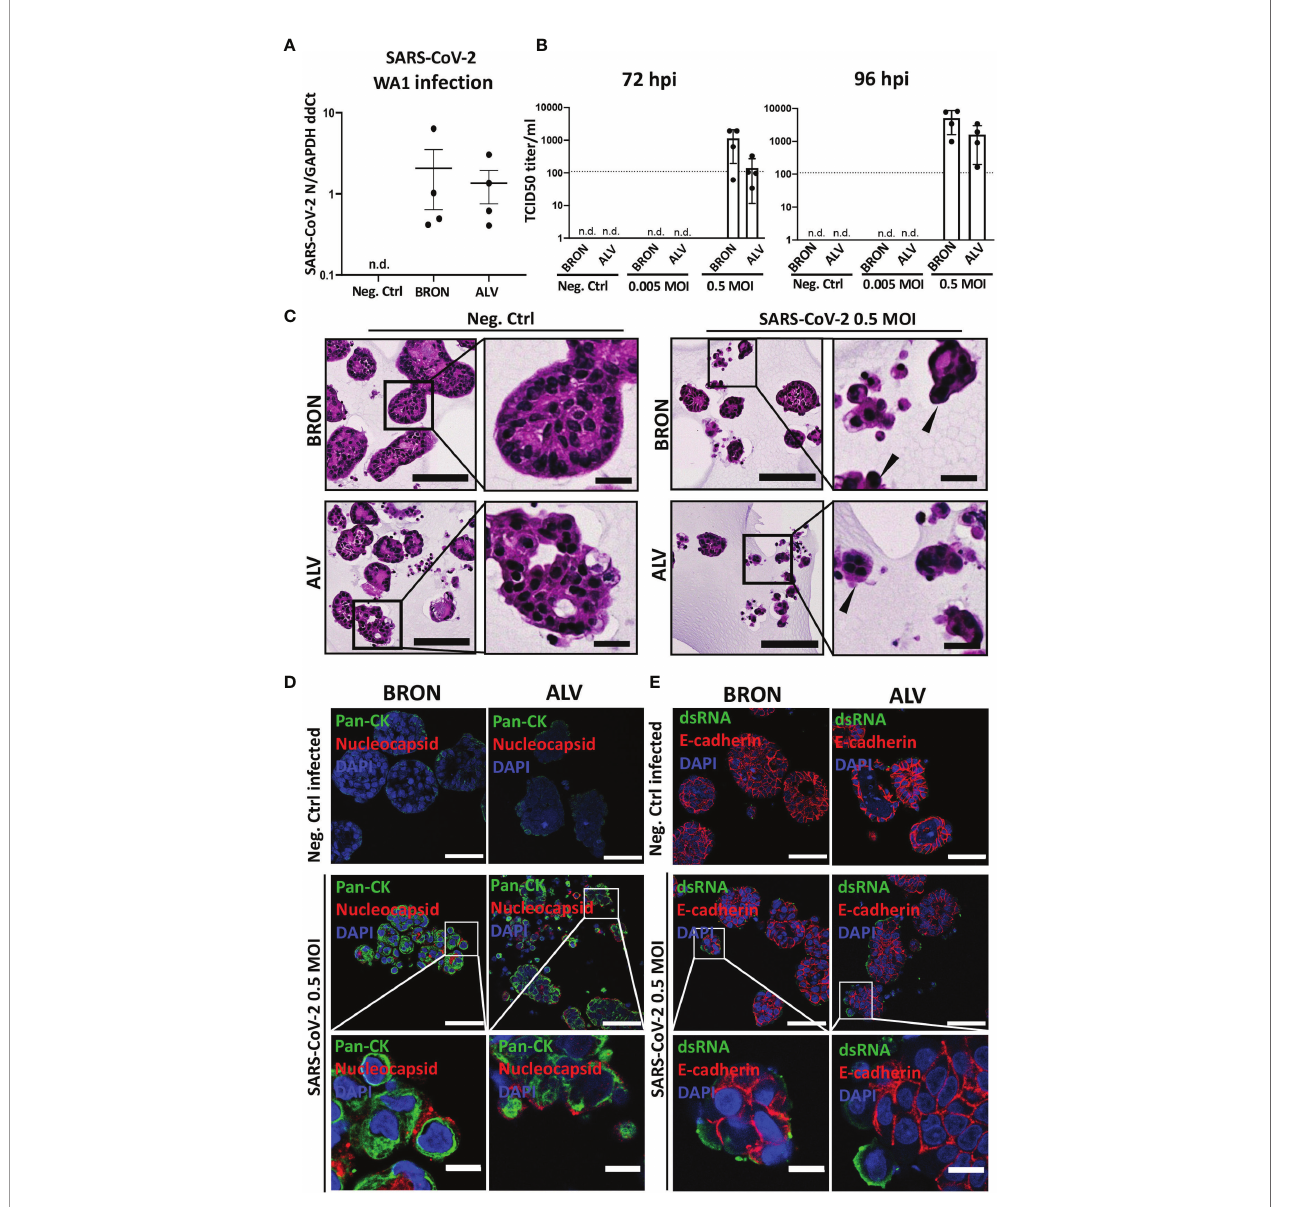
FIGURE 7 | Infection of human BRON and ALV organoid by two clinical isolates (WA-1 and hCoV-19/Norway/Bergen-01/2020) of SARS-CoV-2 virus. (A) RT-qPCR was used to detect the expression of the SARS-CoV-2 N gene in bronchiolar organoids infected with a clinical isolate of SARS-CoV-2-WA1 (Washington strain), using the SYBR green method. Data is shown as 2 ^ -(avg Ct SARS-CoV-2 N – avg Ct GAPDH), n.d., not detected. (B) Replication of SARS-CoV-2 in organoids of BRON and ALV differentiation was assessed by infection of organoid cultures at multiplicity of infection (MOI) of 0 (Neg.Ctrl), 0.005 or 0.5. Titration of harvested supernatants were performed by TCID50 assay on Vero cells (CCL-81, ATCC). Bar-charts display the quanti fi cation of organoid supernatants harvested 72 h post infection (left) and 96 h post infection (right). For each condition the mean +-SD of four biological replicates is shown, n.d., not detected. (C) Histopathology of bronchiolar (BRON) and alveolar (ALV) organoid cultures, mock infected (Neg.Ctrl.) or SARS-CoV-2 infected at MOI of 0.5. Samples were harvested 72 hours post infection, and FFPE sections stained by H&E. Formation of multinucleated cells (syncytia, black fi lled arrowheads) characteristic of SARS-CoV-2 infection in human patient samples were observed in the infected samples. Scale bar in all images equals 100 µm, except zoomed inserts (20 µm). (D) In situ detection of bronchiolar (BRON, left panel) and alveolar (ALV, right panel) organoid tissue cells infected by mock (Neg.Ctrl.) or 0.5 MOI SARS-CoV-2 virus